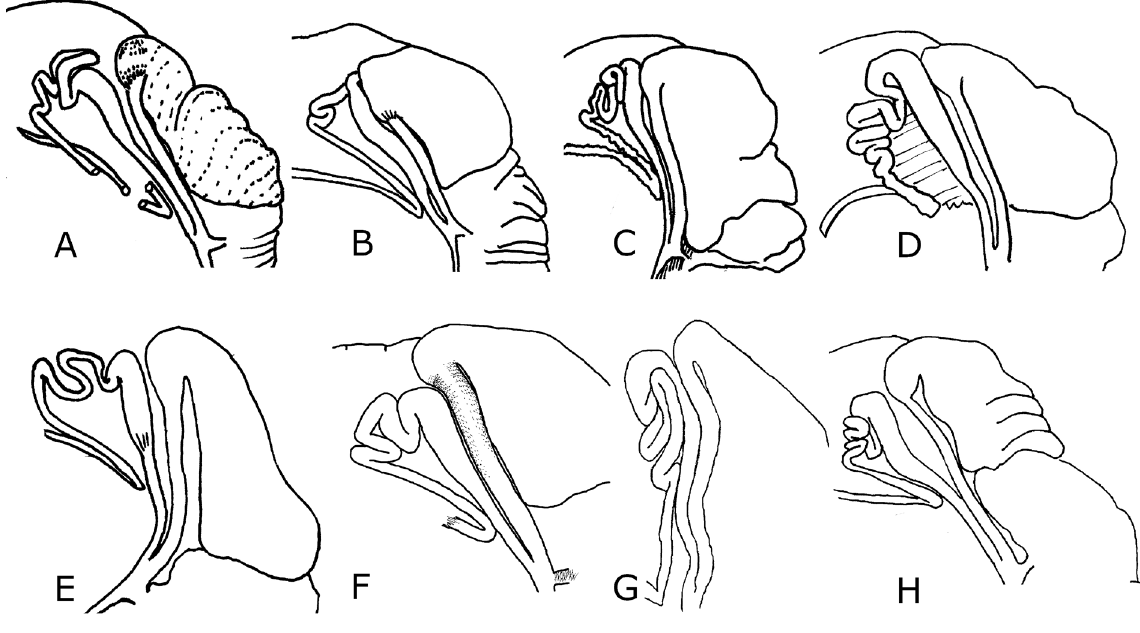
Fig. 32. Variation of the female genitalia in (A.J. Wagner, 1897). A . Polog-E of Čepovan, Slovenia (WdM6842). B . Dol-E of Čepovan, Slovenia (WdM6837). C . Divje Jezero, Slovenia (WdM6840). D . Tisovec, Slovenia (WdM6749). E . Vrsic Pass, Slovenia (EZ0896). F . Benete, Slovenia (WdM6805). G . Vitunin spring, Croatia (EZ0903). H . Mt Klek, Croatia